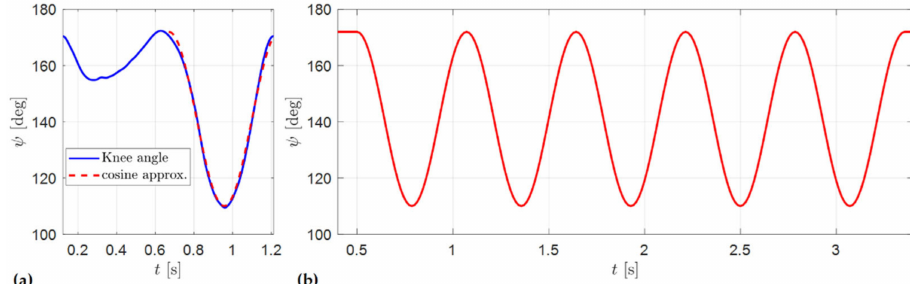
Figure 28. ( a ) Knee angle and a cosine curve approximation in the swing phase; ( b ) the repeating cosine curve used as the test trajectory.